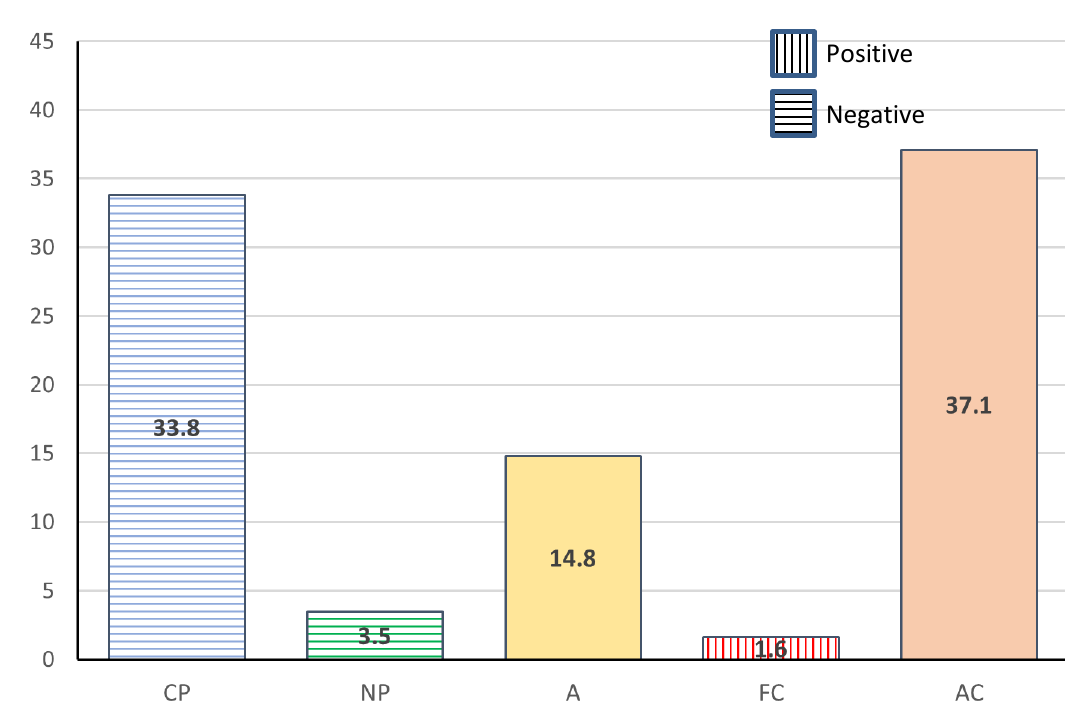
Figure 2: Attempted Suicide Egogram